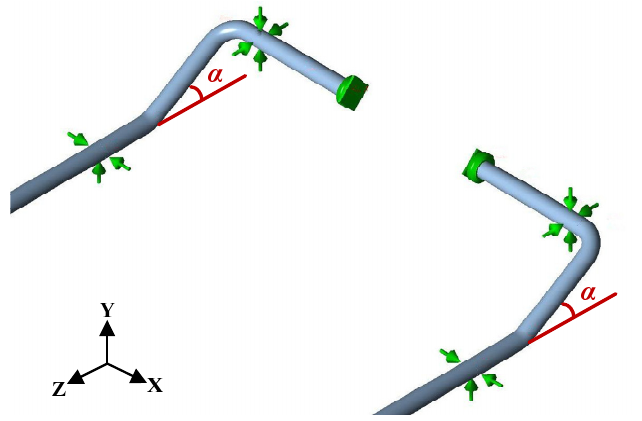
Figure 16. The angle α between the compressor inlet (outlet) pipe and ground.